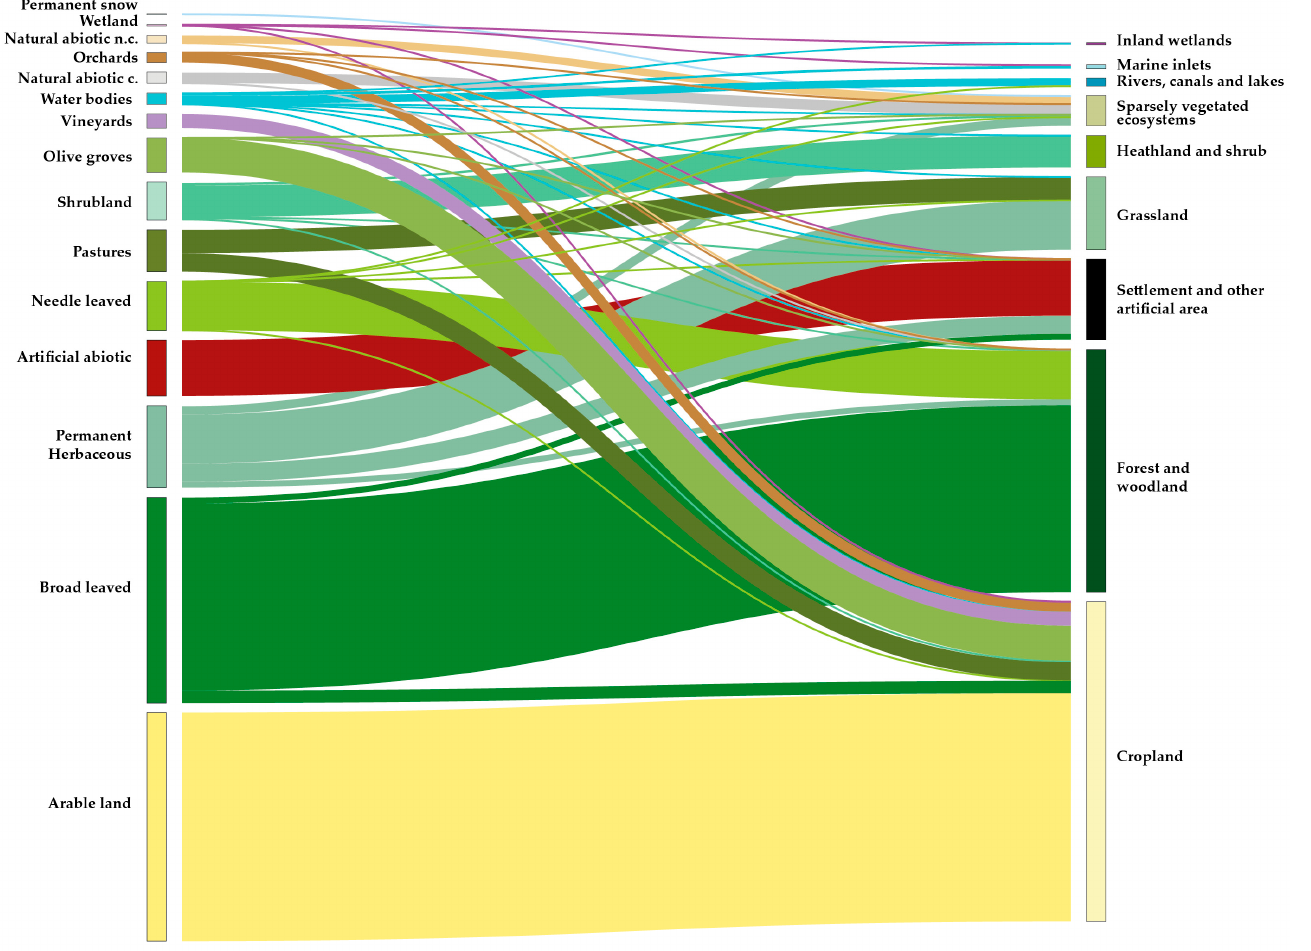
Figure 11. Flows of land cover and land use classes within the types of ecosystems.